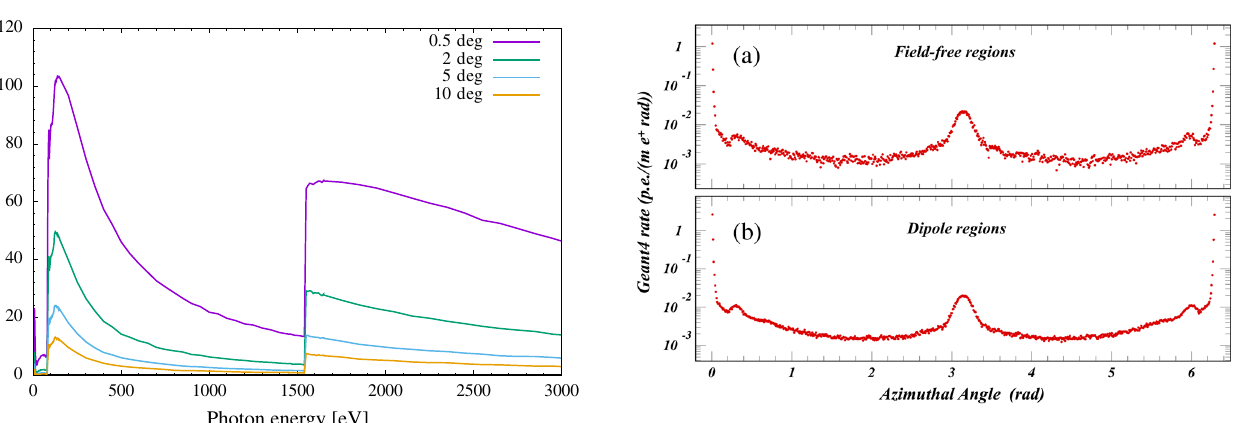
FIG. 17. Quantum efficiency versus photon energy for photons incident at grazing angles between 0.5° and 10° for the aluminum alloy 6061 as modeled in G EANT 4.